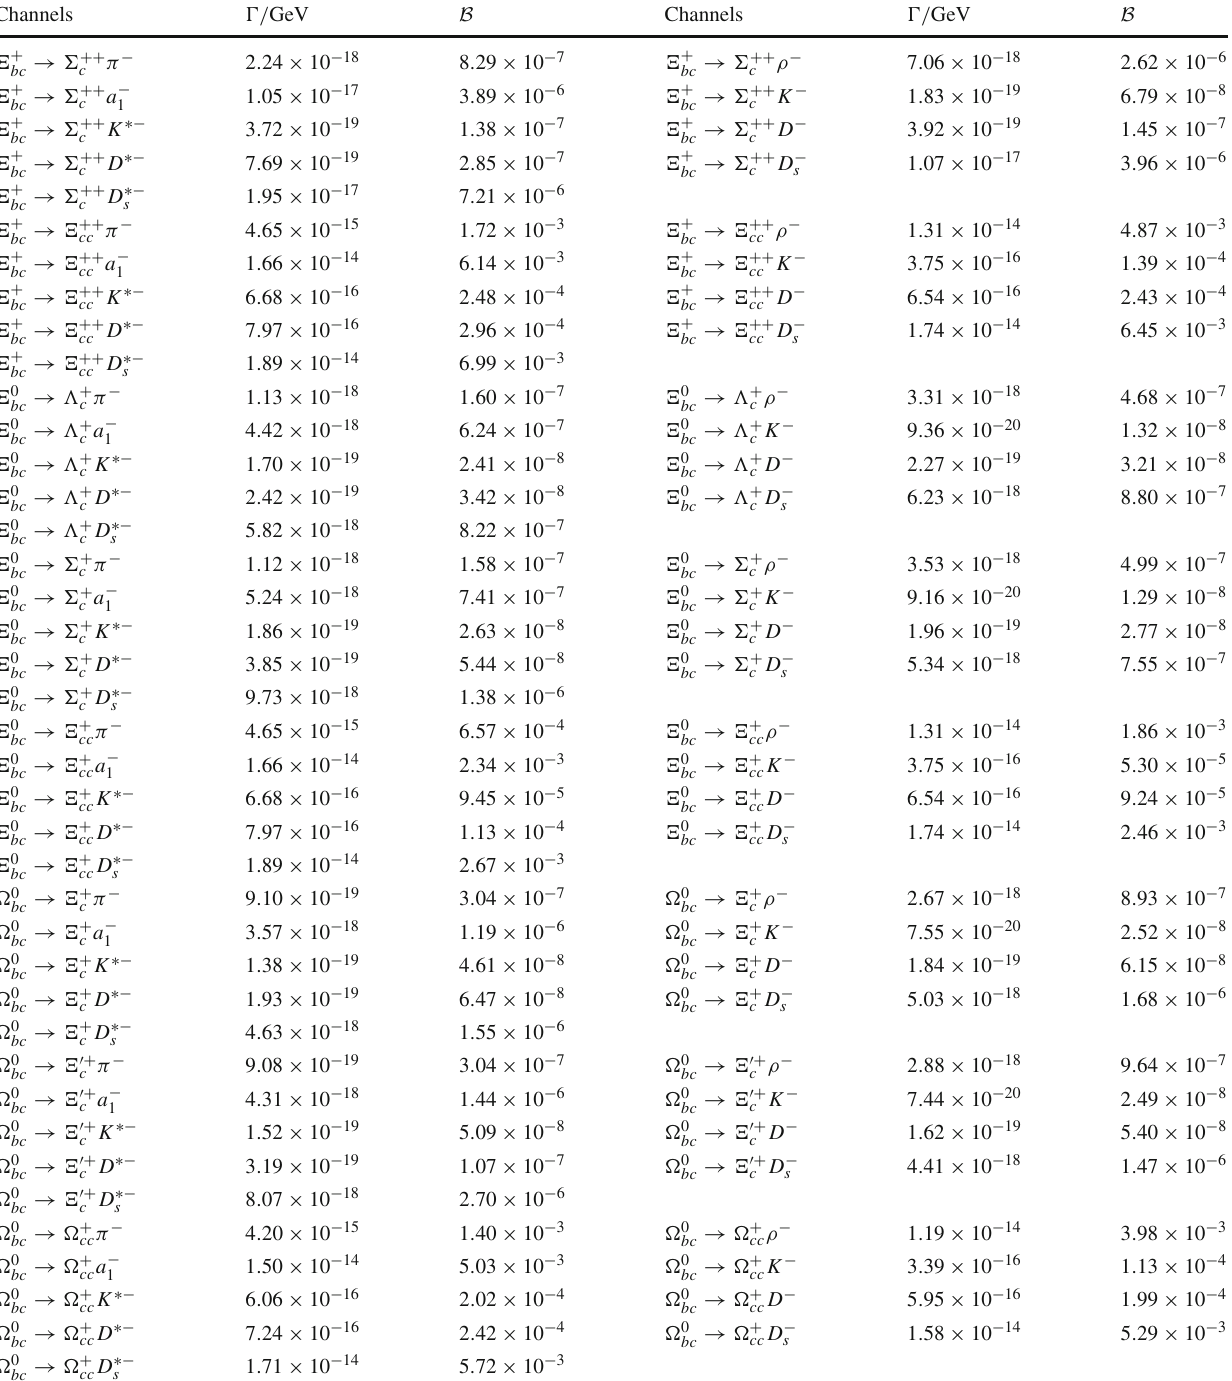
Table 28 Partial decay widths and branching ratios for nonleptonic decays: the bc sector with the b quark decay and an axial vector bc diquark in the initial